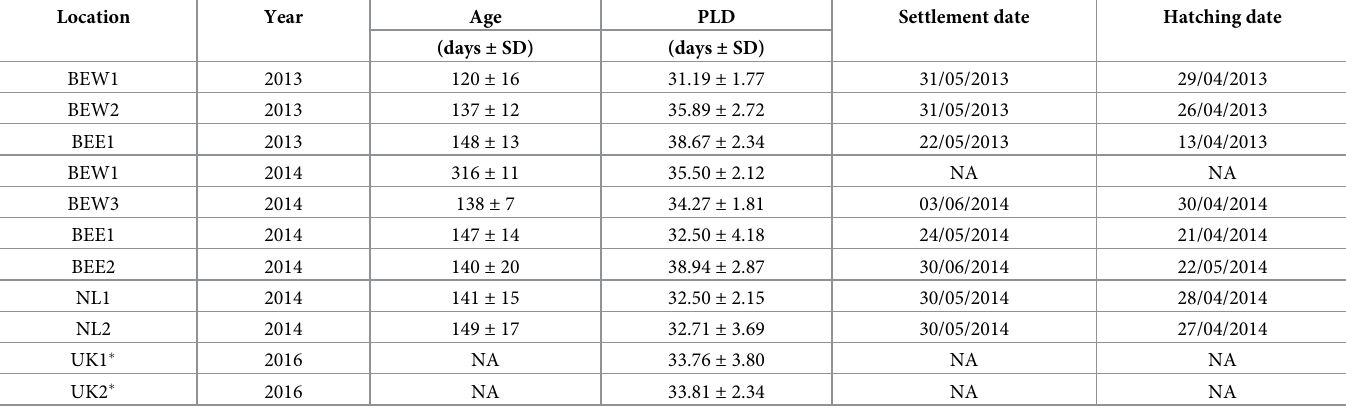
Table 2. Averaged age at capture and PLD (expressed in days), derived from the individual otolith daily growth increment counting averaged per location, next to the back-calculated mean settlement and hatching dates for the different locations. Location